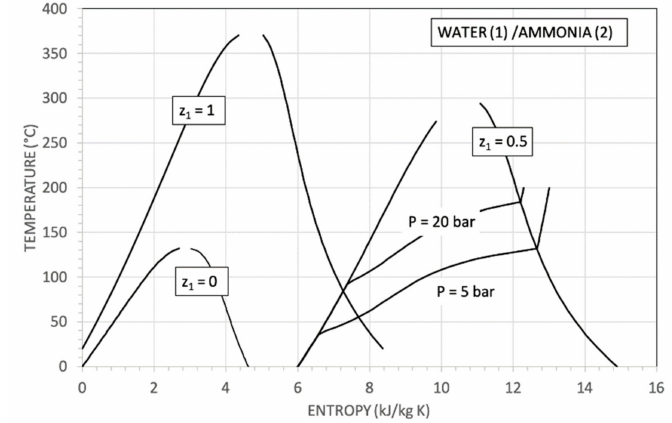
Figure 1. Saturation curves (bubble and dew lines) in temperature–entropy (T–S) plane for water / ammonia mixtures with di ff erent compositions. z 1 = 1 and z 1 = 0 correspond to pure water or pure ammonia